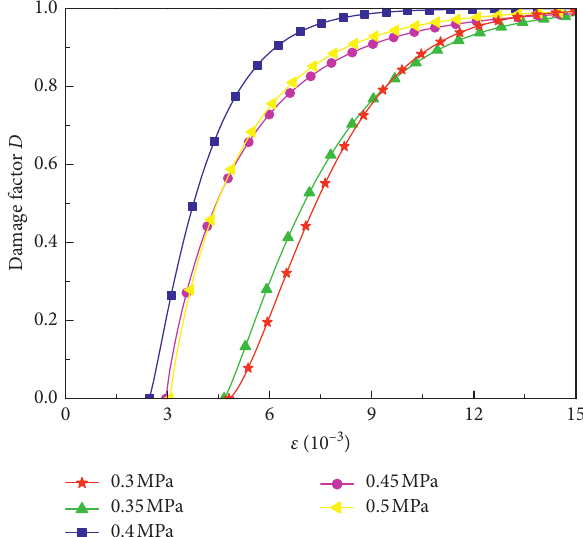
Figure 11: D − ε curve of A3 under different strain